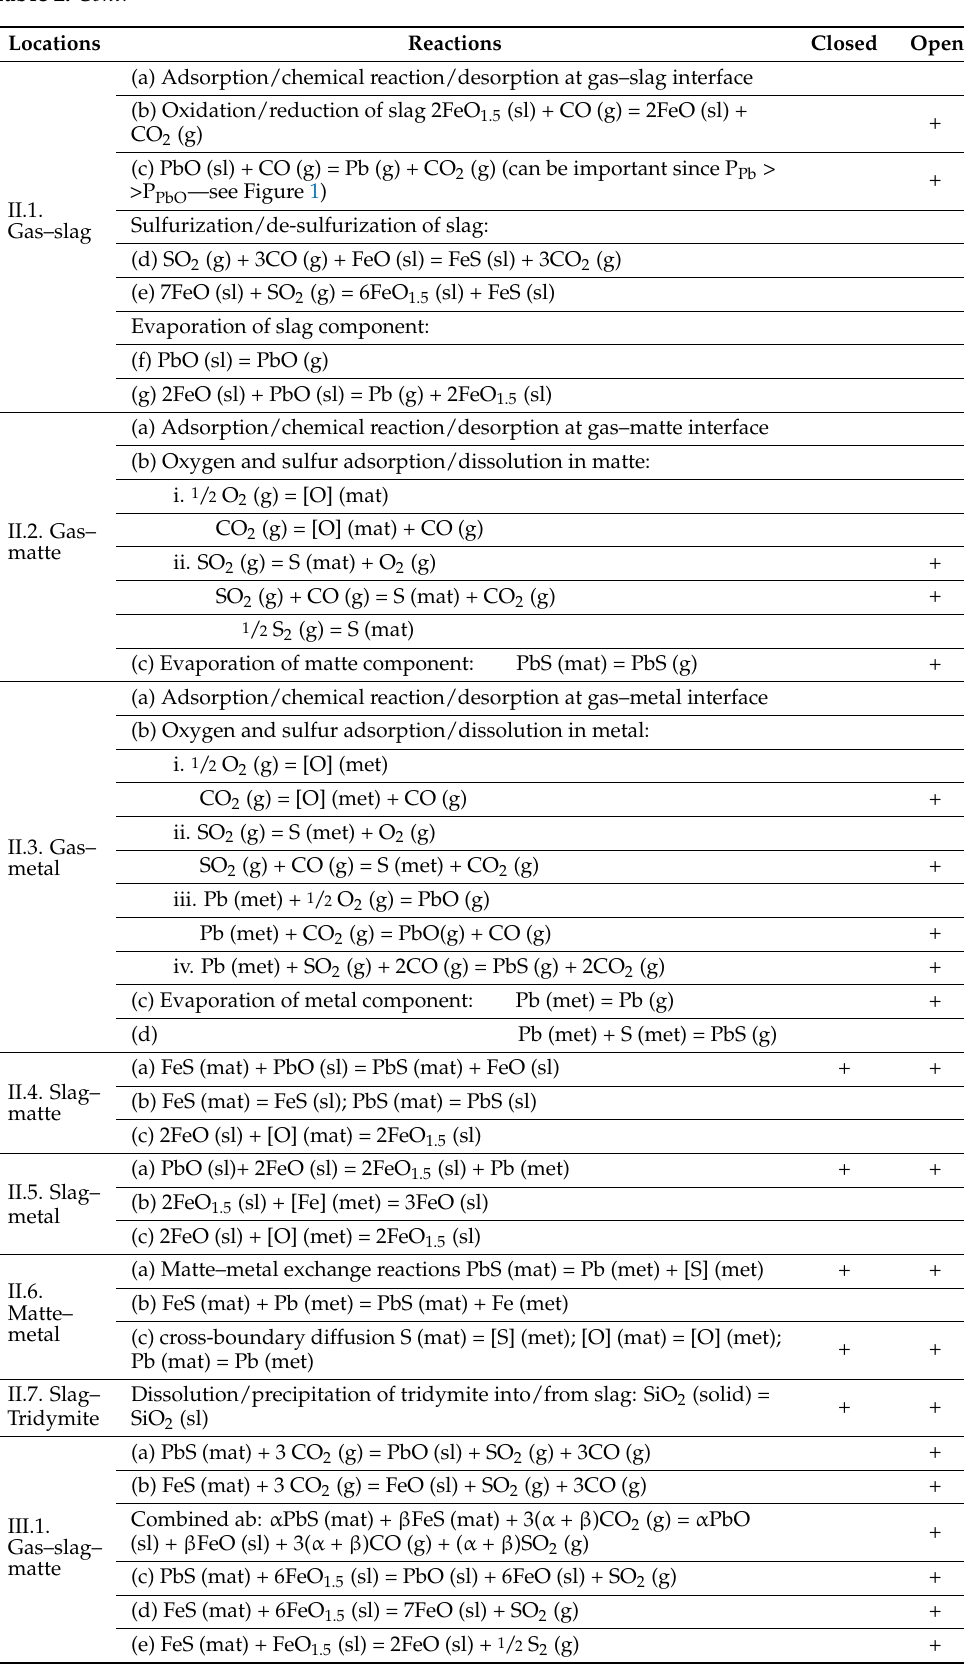
Table 2. Cont. Locations Reactions Closed